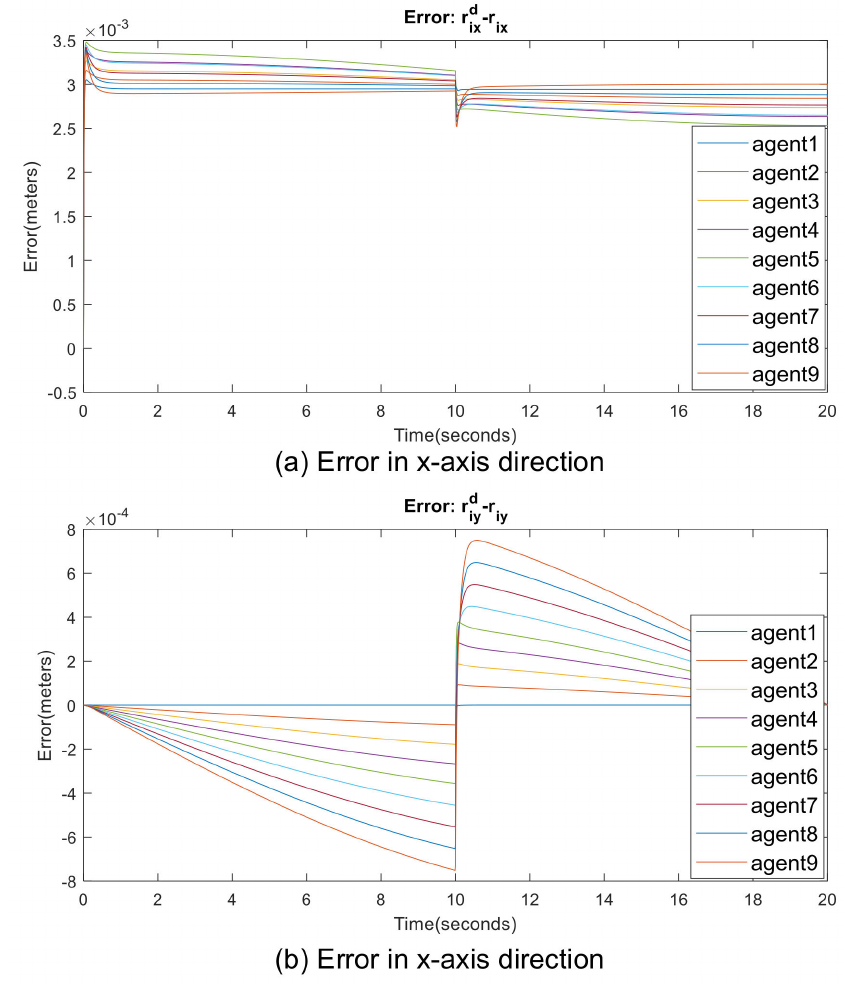
Figure 15. Errors between the real position and the desired position of the